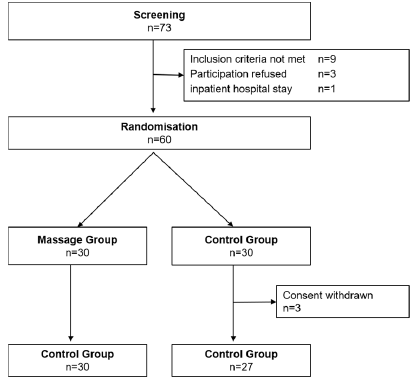
Figure 1. Recruitment and randomization.